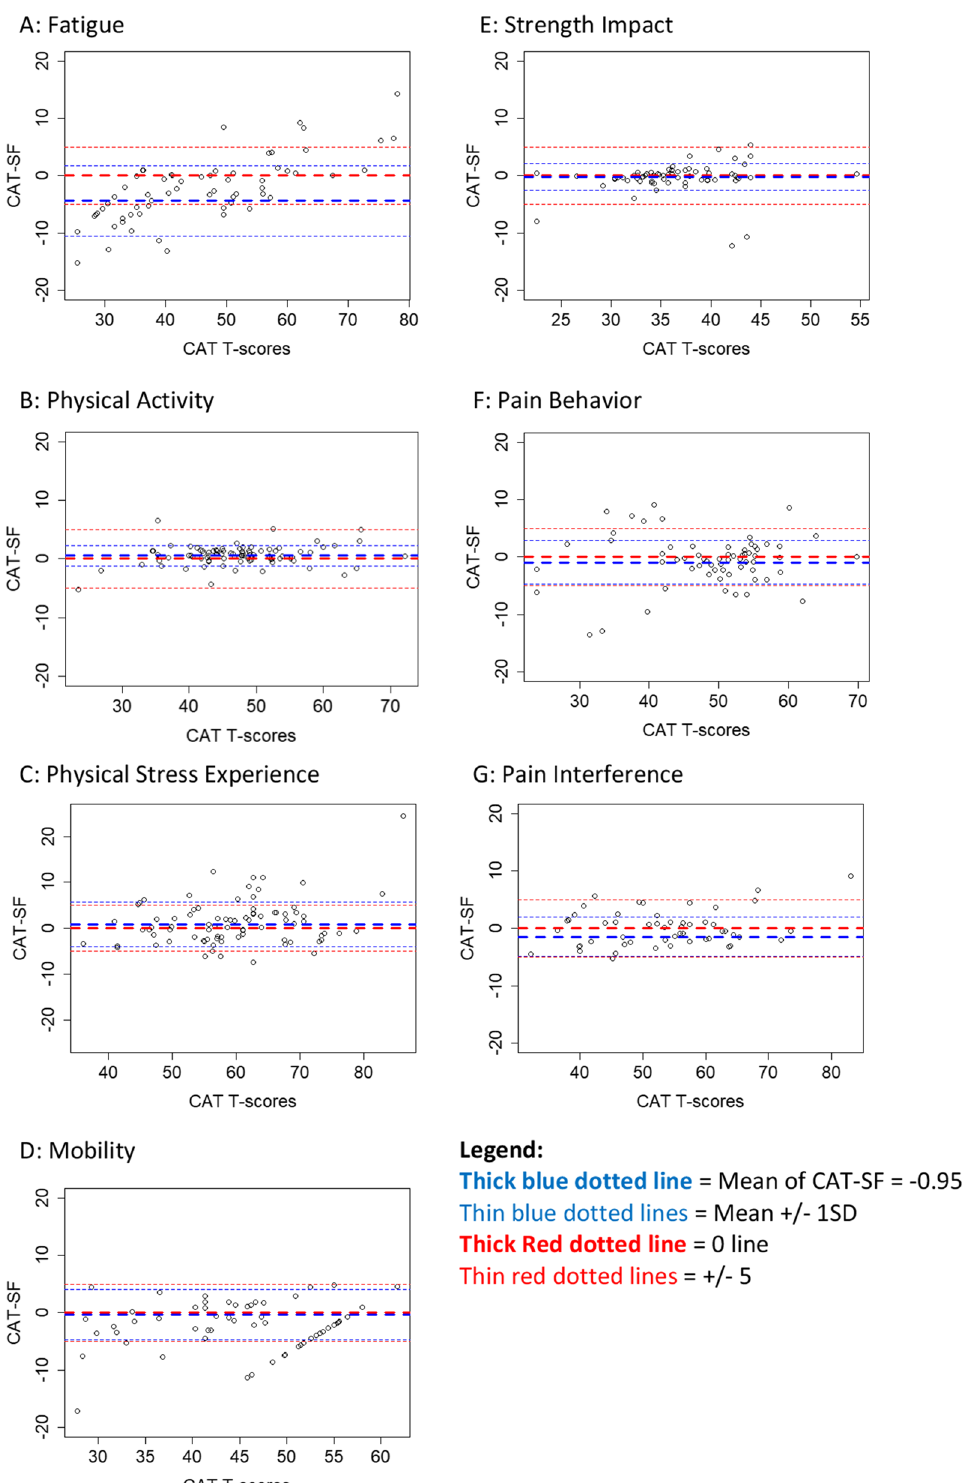
Fig. 2 Bland–Altman plots determining agreement between CAT and SF for each